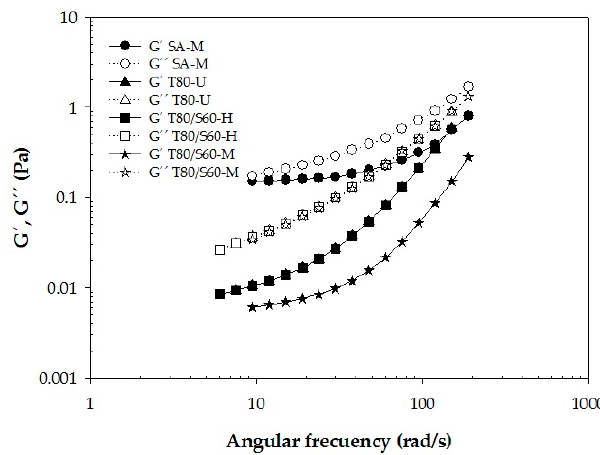
Figure 7. Oscillatory shear curves of beeswax–starch nanoemulsions. Filled symbols are G’: elastic module and empty symbols are G”: viscous module. Emulsifier type: SA, Stearic acid; T80, Tween 80; T80/S60, Tween 80/Span 60; shear process: H, homogenization; U, ultrasound; M, microfluidization.